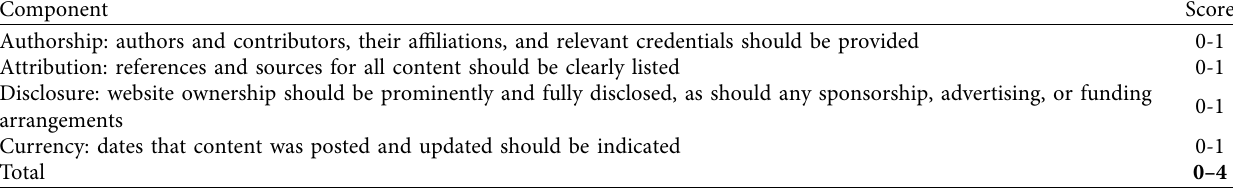
Table 3: Journal of the American Medical Association (JAMA).